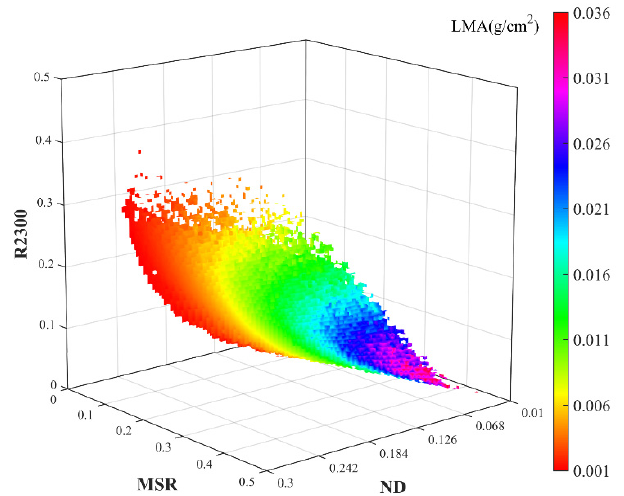
Figure 2. 3D matrix composed of the modified simple ratio (MSR), the normalized difference-type index (ND), and leaf reflectance at 2300 nm (R2300) using dataset T of 200,000 simulations (the converging point locates around MSR of 0.4353, ND of 0.0321, and R2300 of 0.0201).